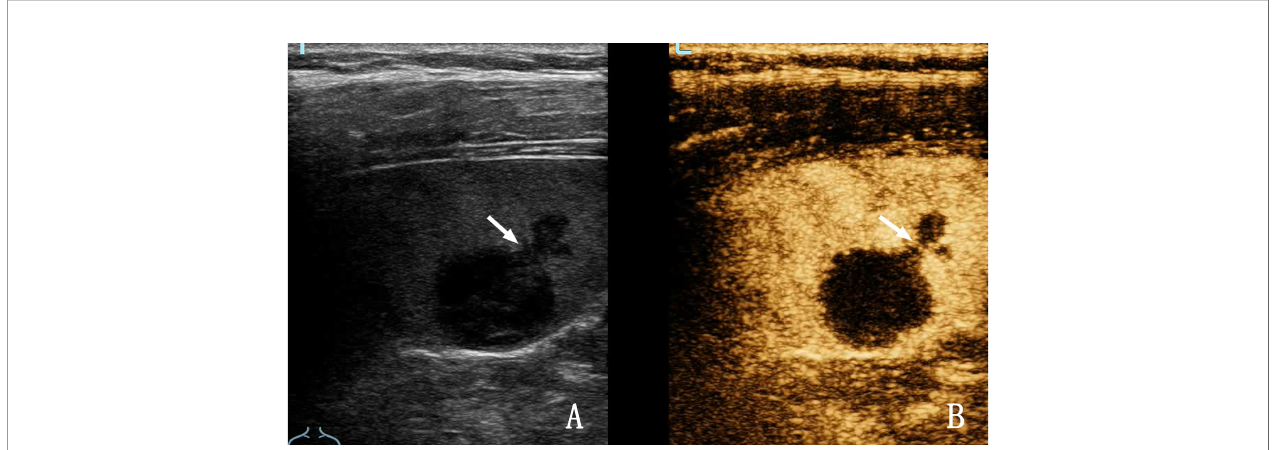
FIGURE 4 | A 32-year-old woman with splenic tuberculosis. (A) Two-dimensional ultrasound (2D US) shows multiple nodules in the splenic region. (B) Contrast- enhanced ultrasound (CEUS) shows that two nodules are conglomerated (arrows), both of which are